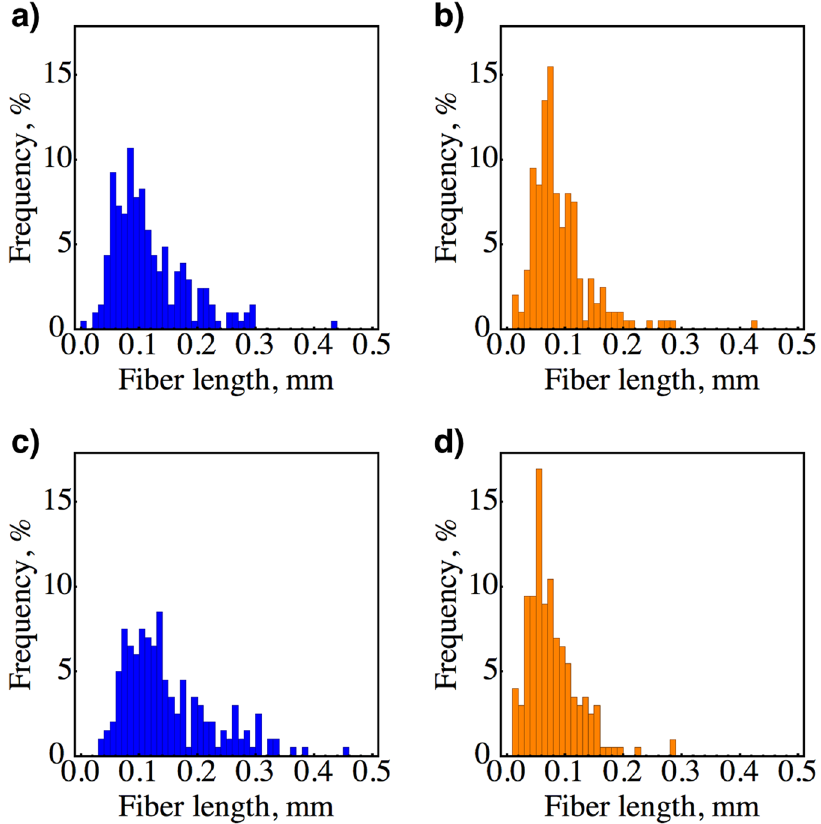
Figure 5. Fiber length distributions for raw filament ( a ) and ( c ), and extruded filament ( b ) and ( d ). The mean carbon fiber lengths and standard deviations are ( a ) 117 ± 65 μ m, ( b ) 91 ± 52 μ m, ( c ) 148 ± 76 μ m, and ( d ) 77 ± 44 μ m. The data in ( b ) was generated from the same same region as ( a ) and the data in ( d ) was generated from the same region as ( c ). In other words, ( a – d ) represent the same region along the filament within ~3